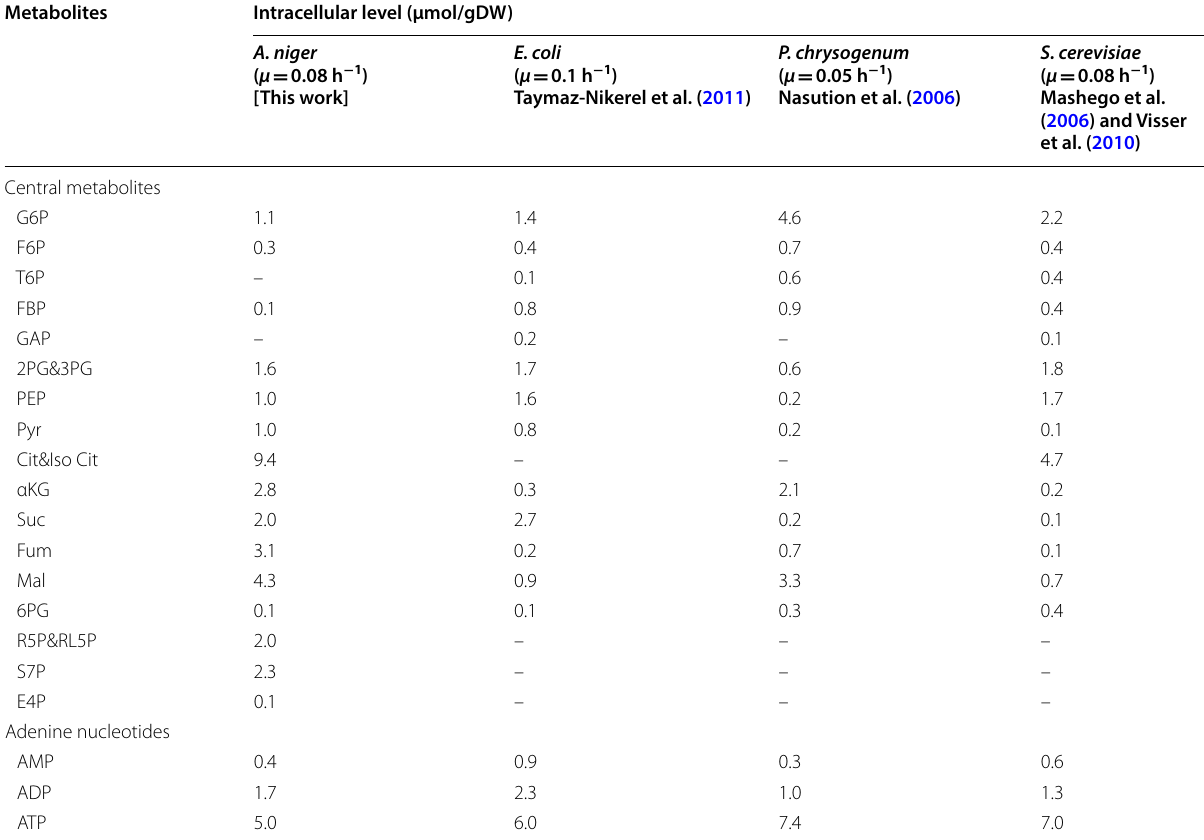
Table 2 Intracellular metabolite concentrations in steady-state glucose-limited aerobic cultures of several organisms